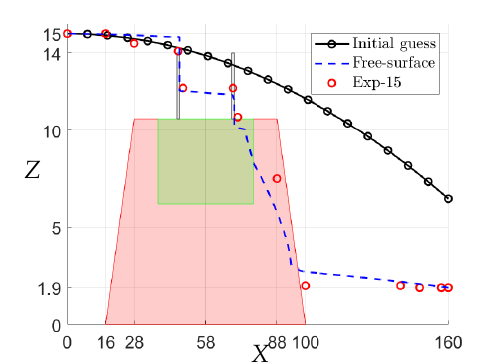
Figure 9. Free-surface of inflow at 15 cm.